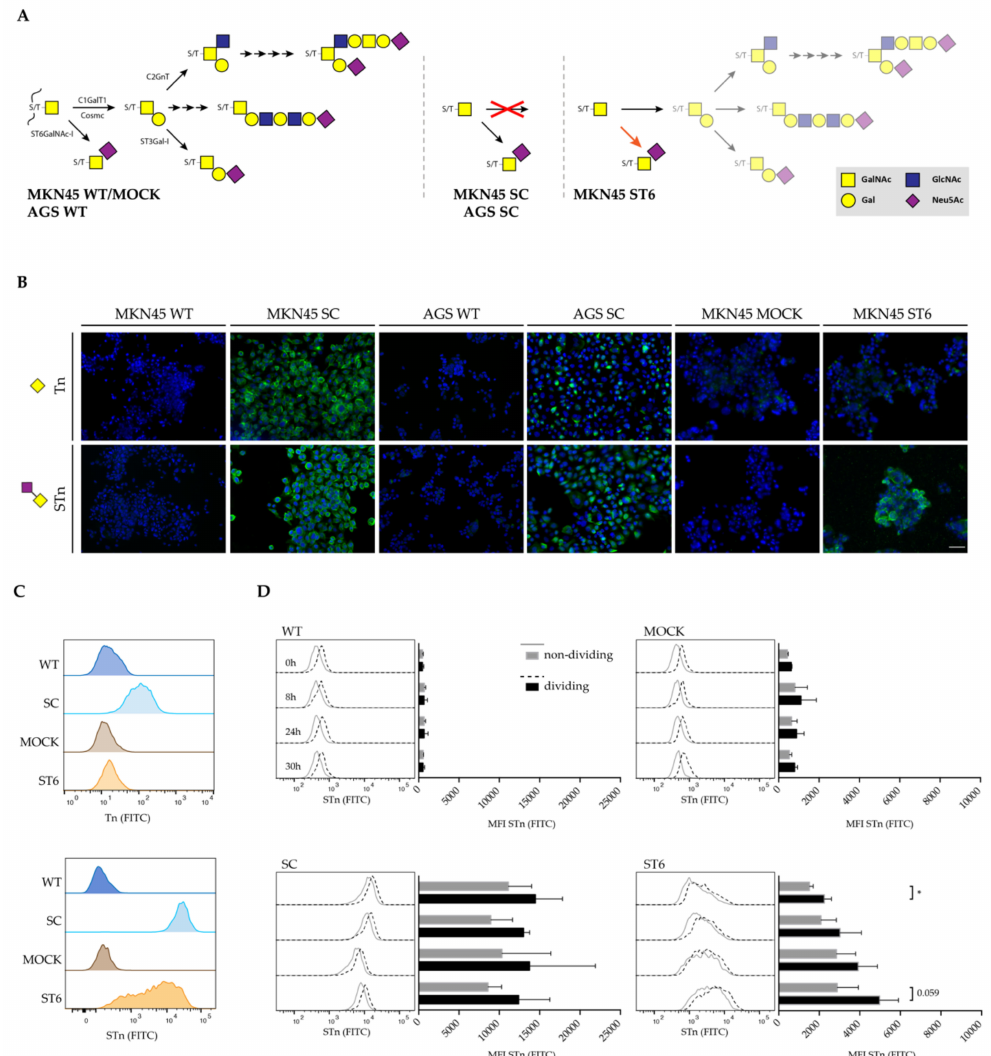
Figure 1. Truncated O -glycans in gastric cancer cell line models. ( A ) Schematic representation of the O -glycosylation pathway of glycoengineered gastric cancer cell line models. ( B ) Immunofluorescence analysis of truncated O -glycans (Tn and STn) in gastric cancer cell line models of O -glycan truncation (MKN45 SC, AGS SC, and MKN45 ST6) and their respective control counterparts (MKN45 WT, AGS WT, and MKN45 MOCK). Nuclei were stained with DAPI and are shown in blue and O -glycan structures in green. The scale bar corresponds to 50 µ m. ( C ) Histograms of Tn and STn fluorescence signal in flow cytometry in MKN45 glycoengineered cell line models, SC and ST6, as compared to their control cell lines, WT and MOCK. Data are representative of three independent experiments. ( D ) Median fluorescence intensity (MFI) quantification of fluorescence signal related to STn expression in MKN45 glycoengineered cell models, SC and ST6, as compared to their control counterparts, WT and MOCK, according to cell cycle progression. The analysis resulted from di ff erent incubation times (0 h, 8 h, 24 h, and 30 h), after cell cycle synchronization through 24 h of serum starvation. All MFI levels were subtracted from the negative control intensity. Data are representative of at least three independent experiments. * p <